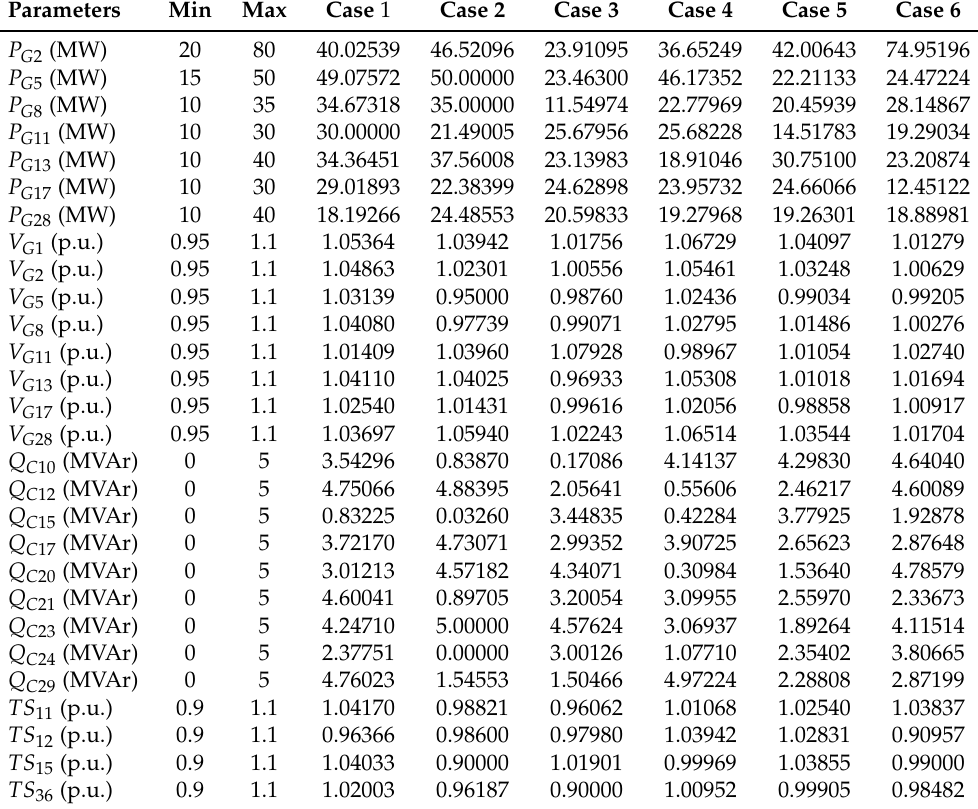
Table A11. Optimal solution obtained by GROM for single-objective OPF for IEEE 30-bus Modified (2).